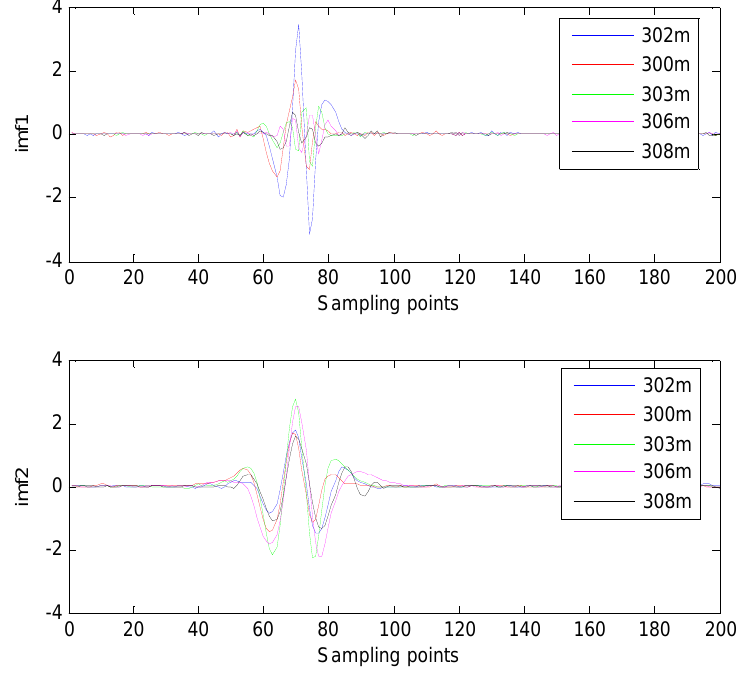
Figure 16. Waveforms of IMF 1 and IMF 2 from different ECG